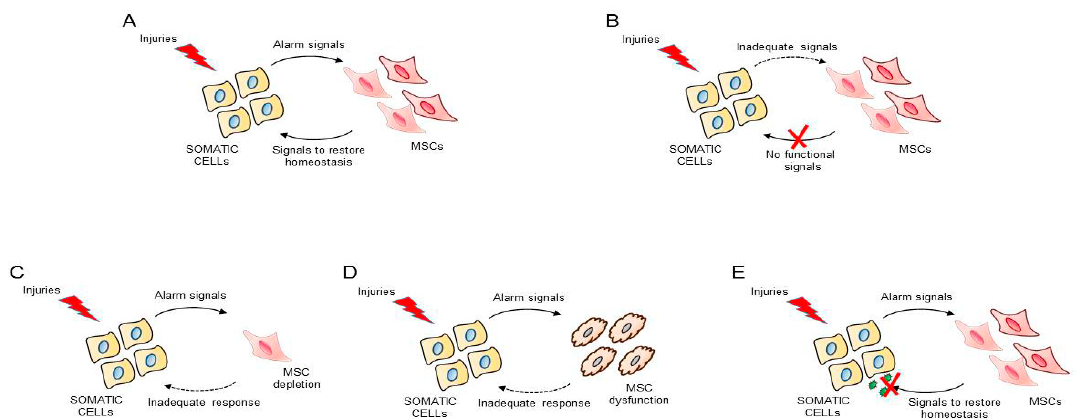
Figure 1. Possible intercellular communication stages between somatic cells and MSCs: ( A ) damaged somatic cells might send “alarm signals” indicative of dysfunction to “resident sentinel” MSCs which would trigger their proliferation and activation in response to the damage in the somatic cell, leading ultimately to the production of a specialized secretome (Figure 1A); ( B ) inadequate alarm messages by damaged somatic cells (Figure 1B); ( C ) inadequate response to those alarm signals by MSCs due to their depletion (Figure 1C); ( D ) inadequate response to alarm signals by MSCs due to primary or secondary cell dysfunction, induced by alterations in tissue microenvironment (Figure 1D); and ( E ) inadequate response by somatic cells to the intercellular communication signals coming from MSCs (Figure 1E).